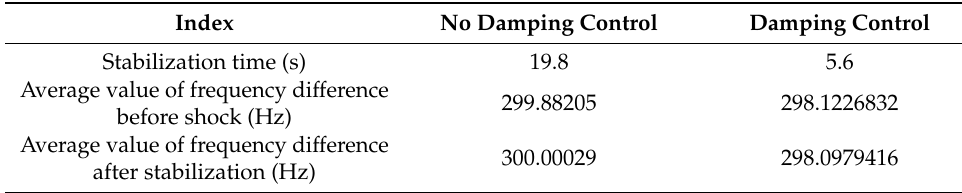
Table 3. Experimental data of half-sine shock